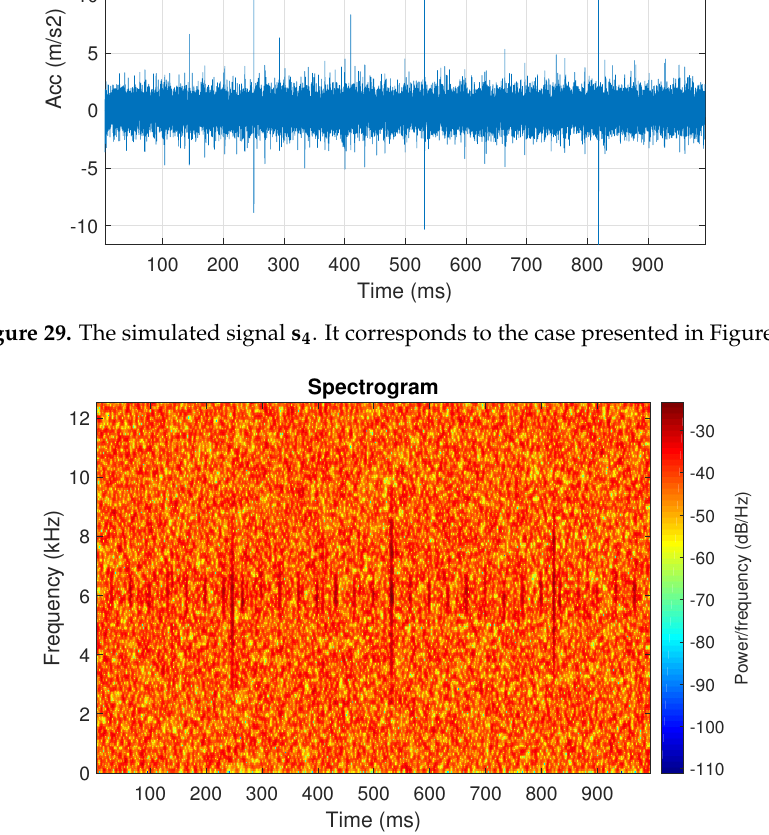
Figure 30. Spectrogram of the simulated signal s 4 .